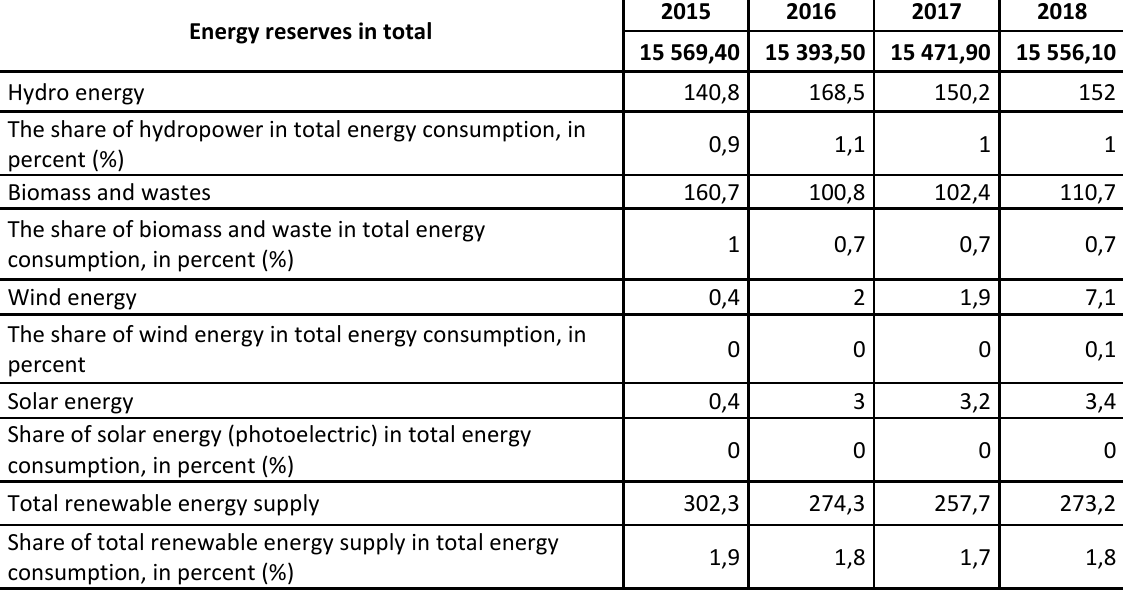
Table 3 Renewable energy supplies in Azerbaijan for